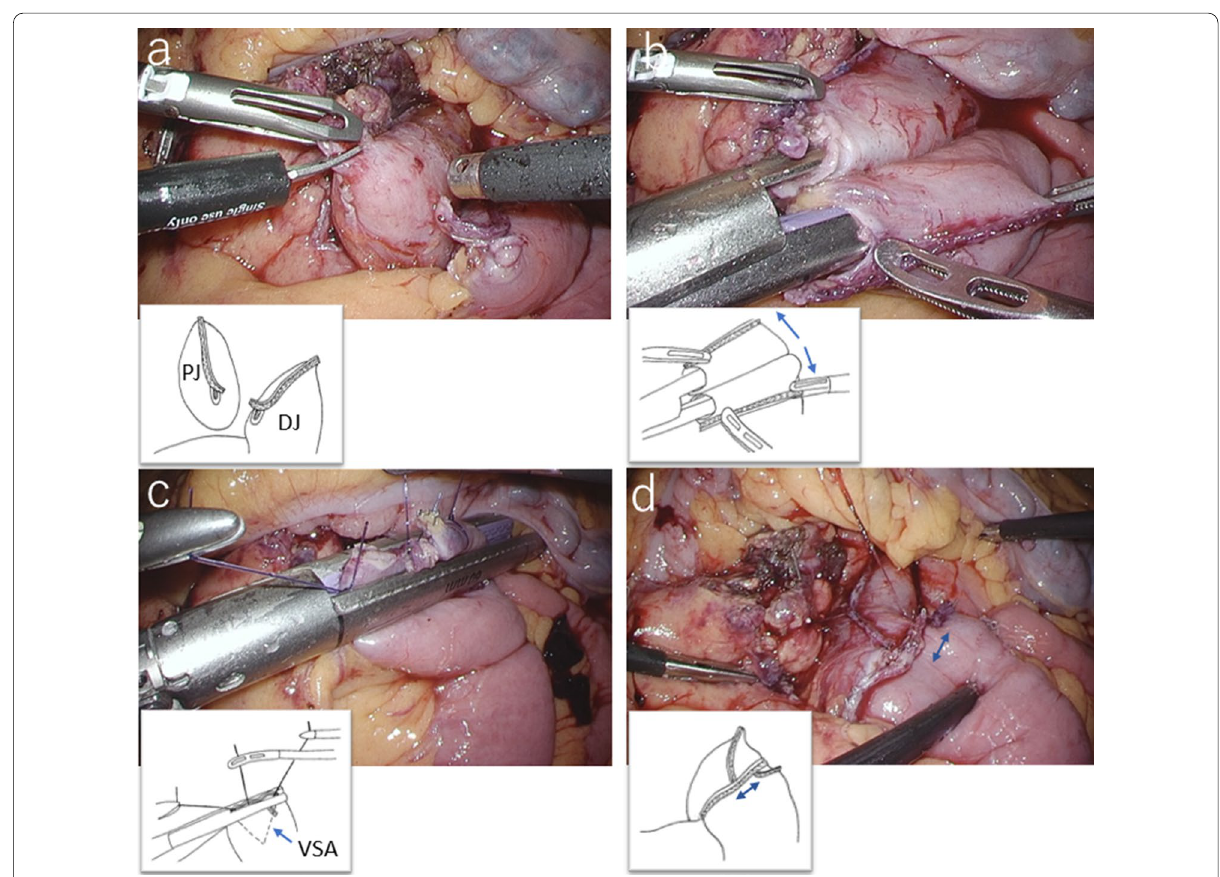
Fig. 4 Procedure for creating a delta-shaped anastomosis. a Small hole was created on the posterior side of the staple line of the proximal jejunum and on the mesenteric side of the staple line of the distal jejunum. b Dorsal walls of the proximal and distal walls of the jejunum were stapled with sufficient distance (arrows) between each other’s staple lines to maintain blood flow. c Common entry hole was temporarily closed by three full-thickness sutures while widening the V-shaped anastomosis made by first stapling and then permanently closed with a stapler. d Jejunojejunostomy was performed using delta-shaped anastomosis (double arrow: an appropriate gap between the staple lines of the proximal and distal jejunum stumps maintained the physiological axes of the intestinal tract). PJ proximal jejunum, DJ distal jejunum, VSA V-shaped